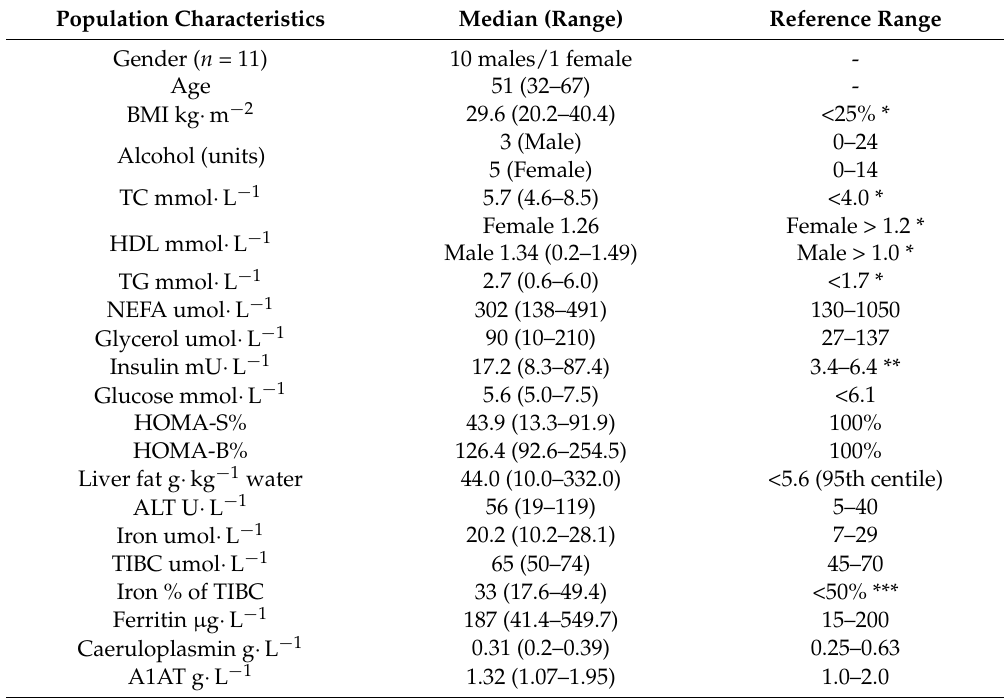
Table 2. Baseline characteristics of study